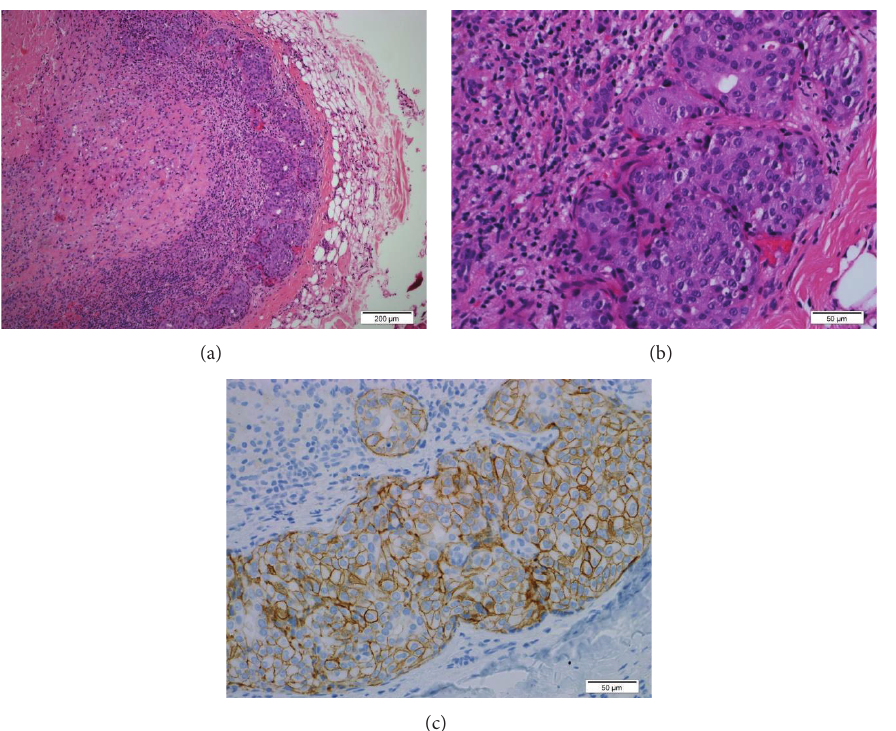
Figure 2: Lymph node H&E stain: (a) central necrosis tumor island in the subcapsular area, (b) adenocarcinoma cells with morphological features similar to Figure 1, and (c) complete membranous staining by HER2/neu immunohistochemical